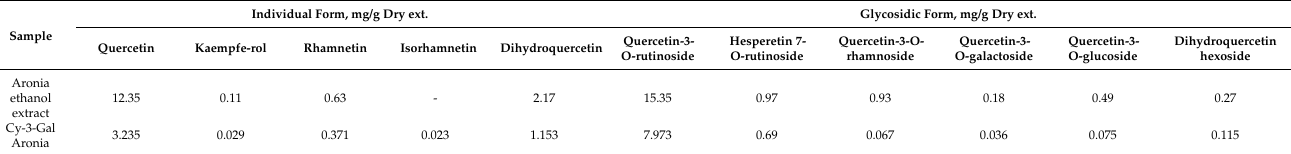
Table 4. Comparative flavonol contents in the extract and anthocyanin fraction. IndividualForm,mg/gDryext. Sample